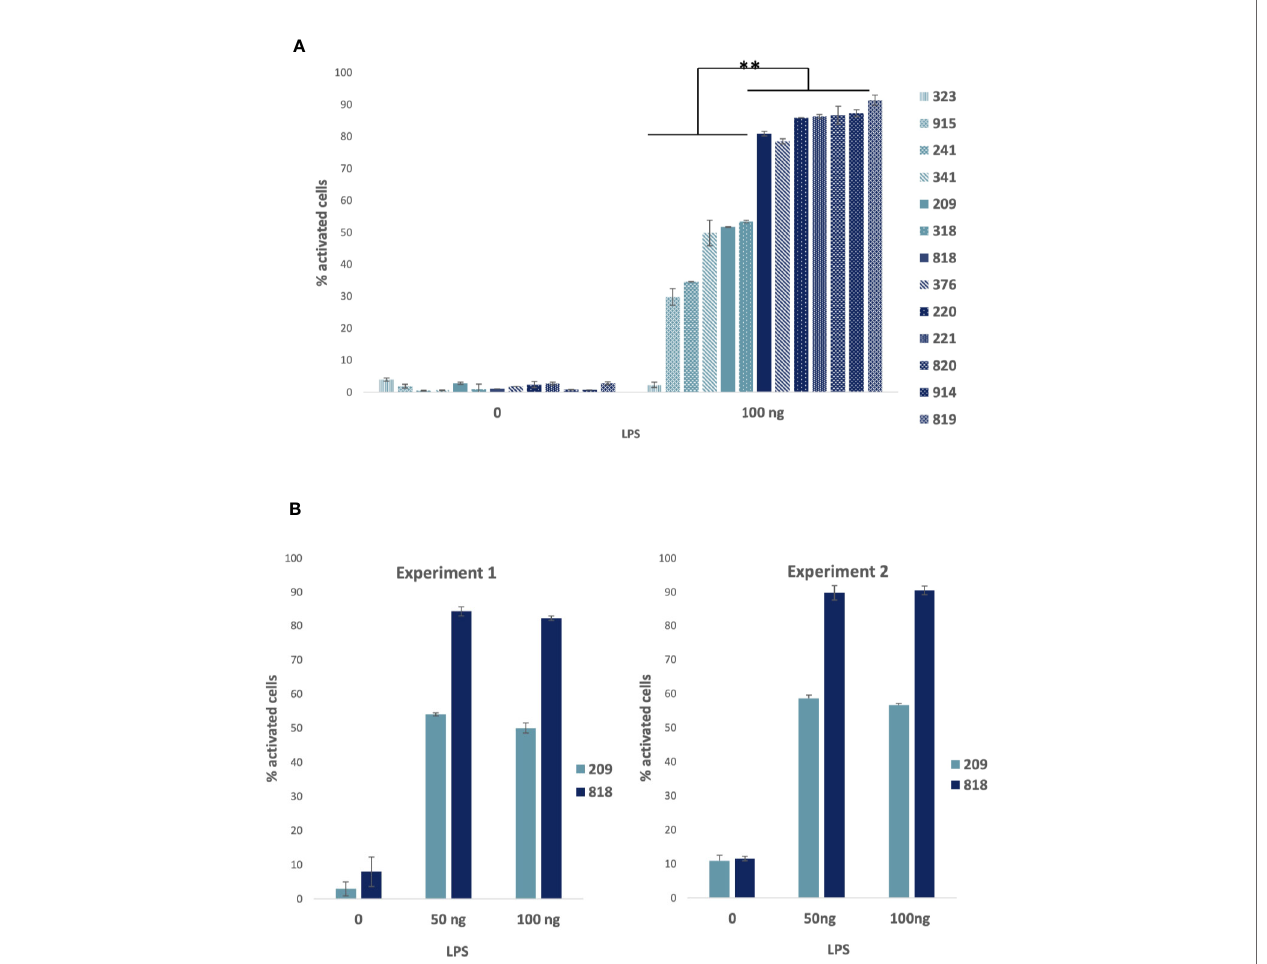
FIGURE 2 | Lipopolysaccharide (LPS) stimulation of healthy fi broblasts. (A) LPS stimulation of 13 primary fi broblasts from the LabEx Milieu interieur collection: Percentage of cells with nuclear NF- k B (activated): compiled results of average percentages presented together for comparison of cells stimulated with 100 ng LPS for 3 h and controls. Bars plot the mean ± sd of triplicates of each experimental point. 209, 220, 221, 241, correspond to women age 30 – 39; 318, 323, 341, 376 to men age 30 – 39; 818, 819, 820 to women age 60 – 69; and 914, 915: men age 60 – 69. Low responders are shown in light blue and high responders in dark blue. Statistical analyses were carried out using the Mann – Whitney-U-Test and p values < 0.05 were considered as statistically signi fi cant. ** Signi fi cant differences between low and high responders. (B) Percentage of cells with nuclear NF- k B (activated) for donors ’ fi broblasts (women: 209, age 30 – 39 and 818, age 60 – 69) activated with 50 and 100 ng of LPS or non-stimulated (0):results of two experiments performed at one year and a half apart. Barsplot the mean ± sdoftriplicates of each experimental point. Chi-square testanalysisofthe results showed that differences between the two experiments were statistically not signi fi cant ata p value <